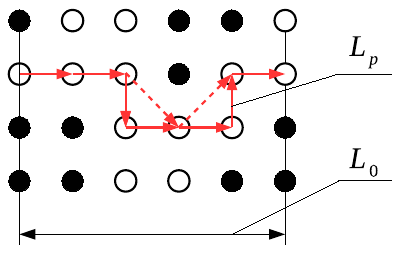
Figure 1. The idea of calculating the so-called binary